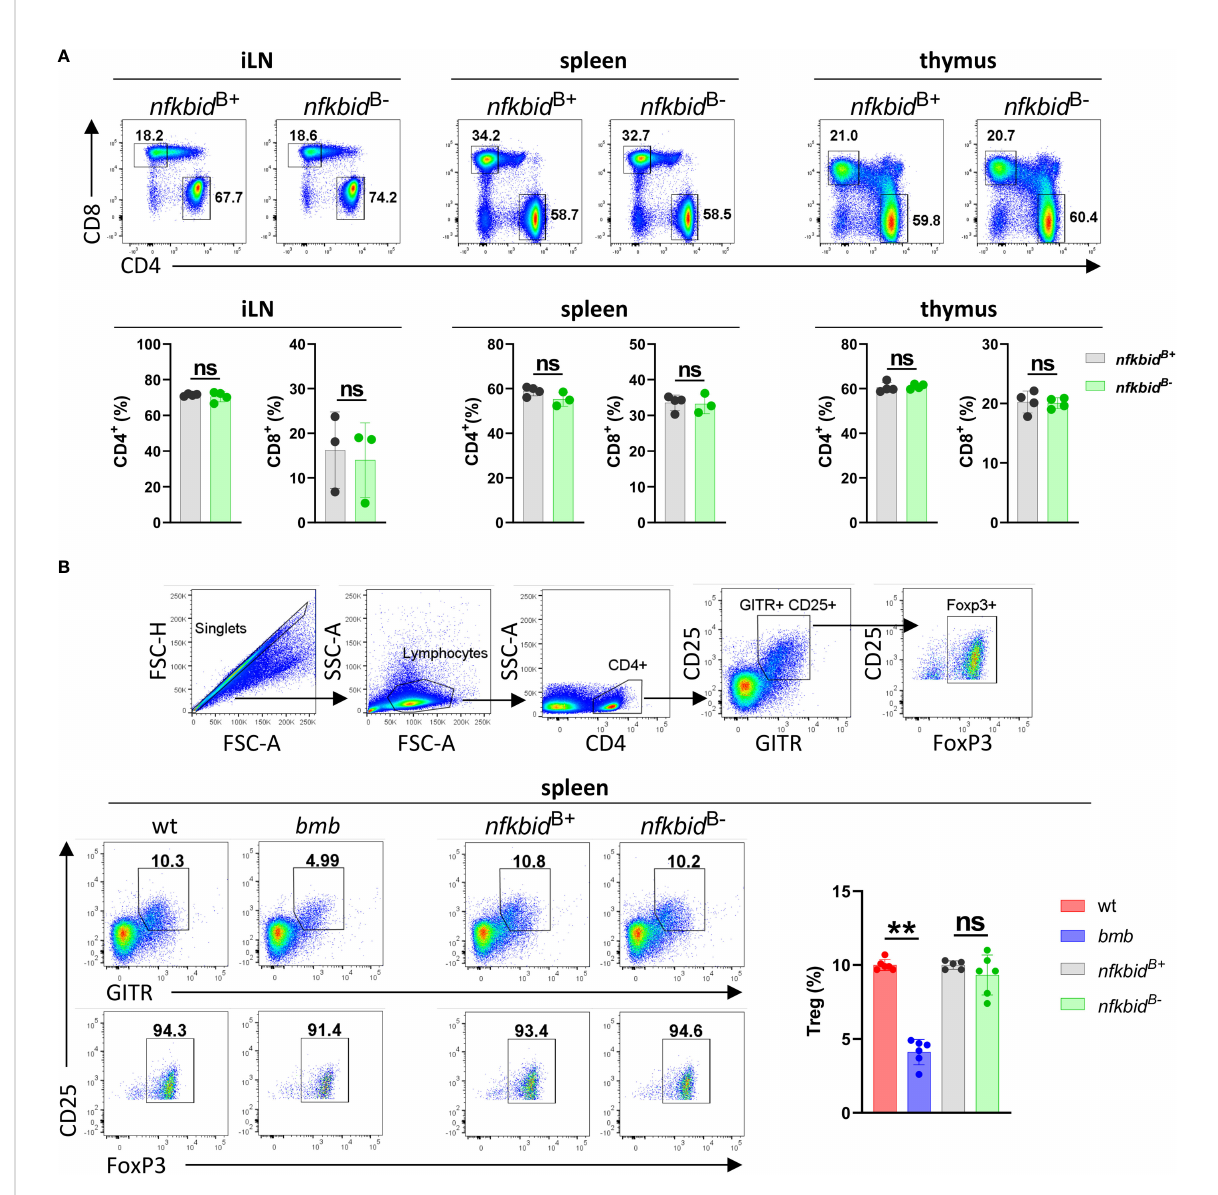
FIGURE 2 Intact T cell compartments in the nfkbid B- conditional knock-out mice. (A) Representative fl ow cytometry plots showing gating strategy for CD4 + and CD8 + T cells in inguinal lymph nodes (iLN), spleen and thymus (upper row). Cell populations shown are pre-gated as B220 - CD3 + . Frequencies of CD4 + and CD8 + T cells (lower row). Data is representative of three experiments with 3-5 mice per group. (B) Flow cytometry plots showing gating strategy for CD4 + CD25 + GITR + FoxP3 + T regs (upper FACS panels). Representative fl ow cytometry plots show T regs (lower row, left FACS panels) and their frequencies within the CD4 + population (right graph bars) in spleen from wt, bumble ( bmb ), nfkbid B+ , and nfkbid B- mice. Data is representative of three experiments with 5-6 mice per group. Numbers adjacent to gates indicate cell frequencies in the parent population. Bars and error bars represent mean ± SD. **for P ≤ 0.01, ns, not signi fi